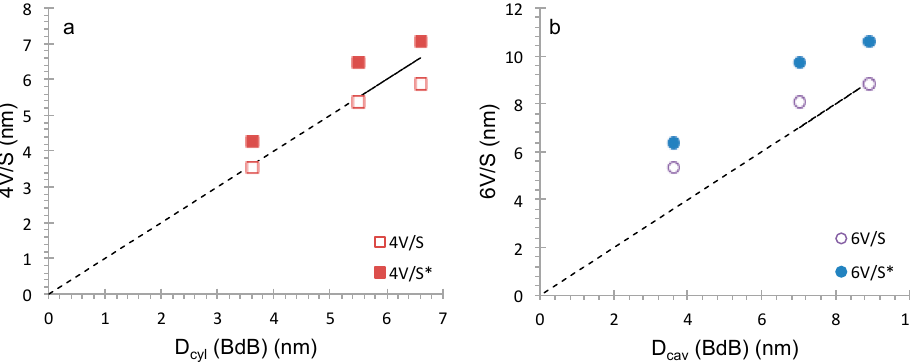
Figure 10. Comparison of mesopore diameters of MCM-41-like monoliths calculated by the geometrical method ( a ) 4 V / S for cylindrical pore hypothesis and ( b ) 6 V / S for spherical pore hypothesis (open square 4 V / S , plain square 4 V / S *, open circle 6 V / S , plain circle 6 V / S *) and mesopore diameters determined by the pressure of capillary condensation with the BdB method as explained in Figure 7. Table 1. Textural properties of ”classical” ordered mesoporous powders synthesized from Aerosil (MCM-41, MCM-48) or TEOS (HMS) as silica source. Materials